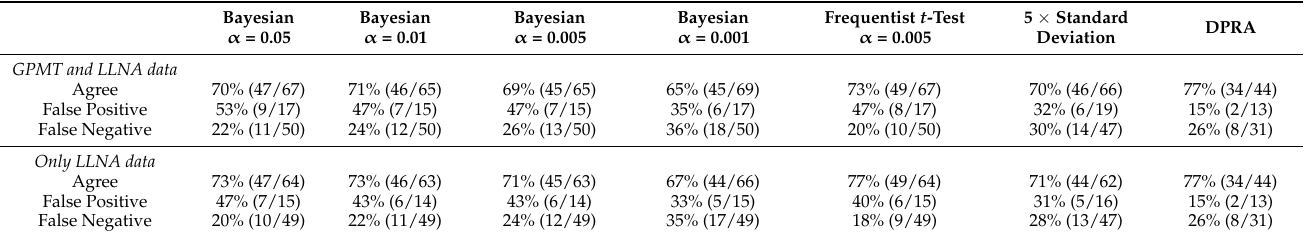
Table 2. Summary of concordance (agree, false positive, and false negative results) for EASA results and those from animal studies.